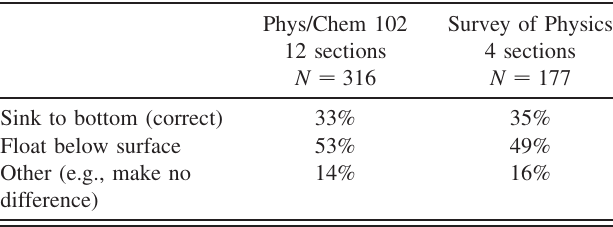
TABLE III. Student responses to the second part of the